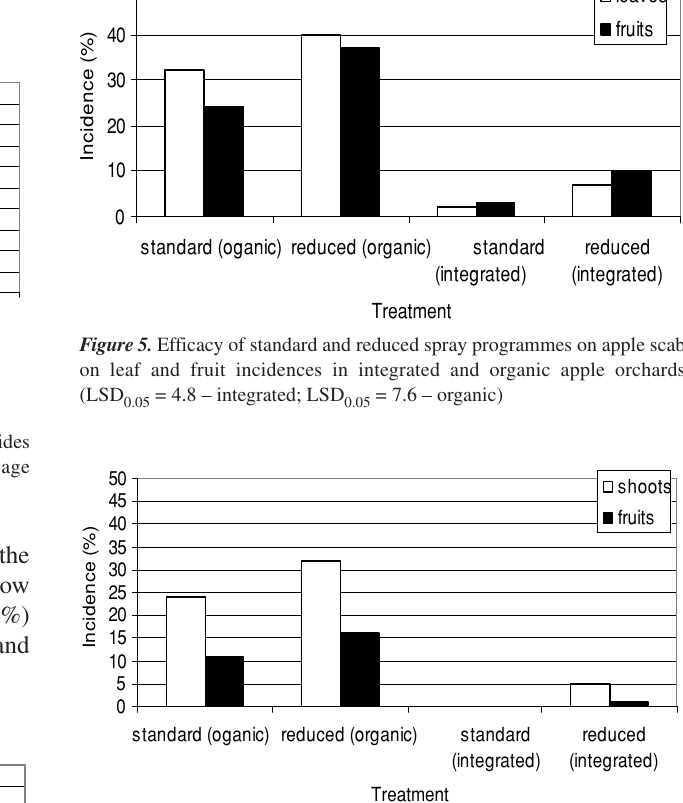
Figure 6. Efficacy of standard and reduced spray programmes on powdery mildew on shoot and fruit incidences in integrated and organic apple orchards (LSD = 3.2 – integrated; LSD = 9.4 – 0.05 0.05